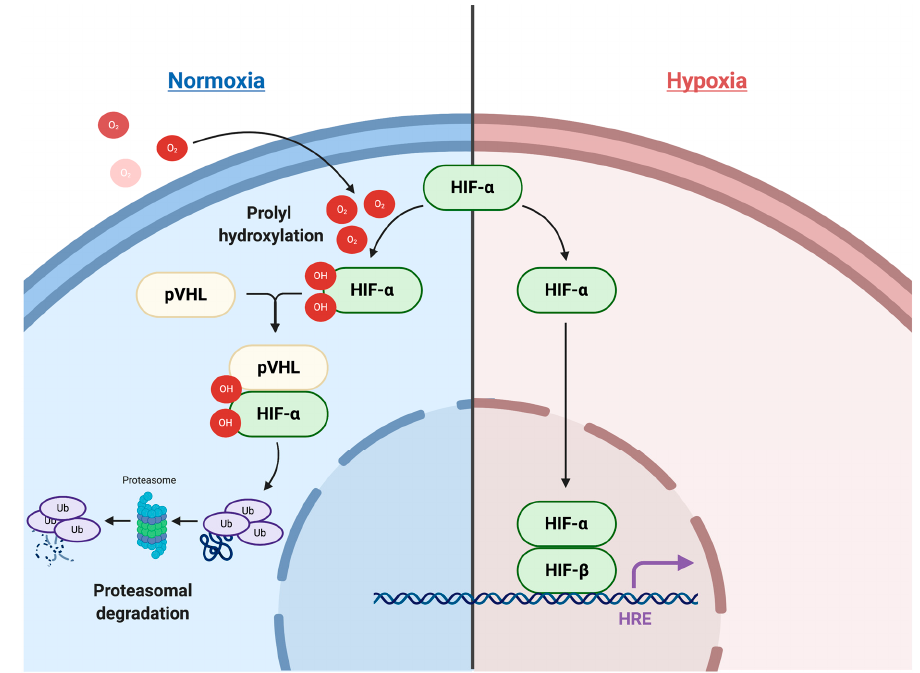
Figure 1. Hypoxia-inducible factor (HIF) signaling pathway.